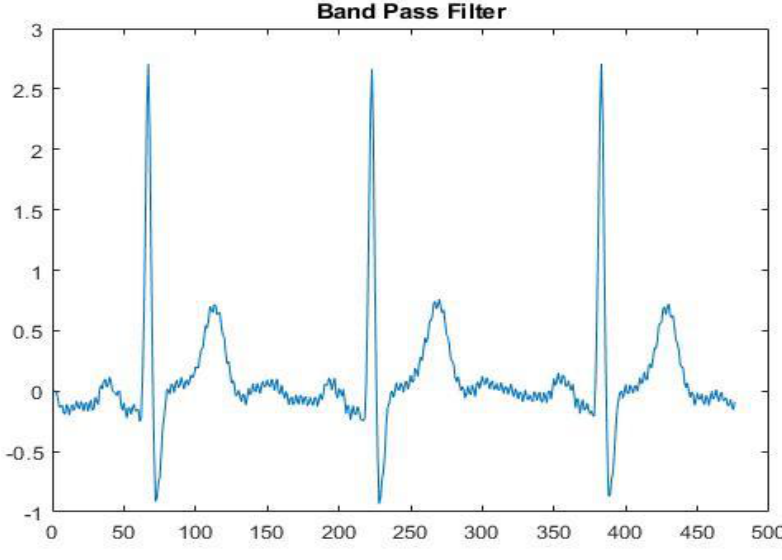
Figure 4. Band pass filter.